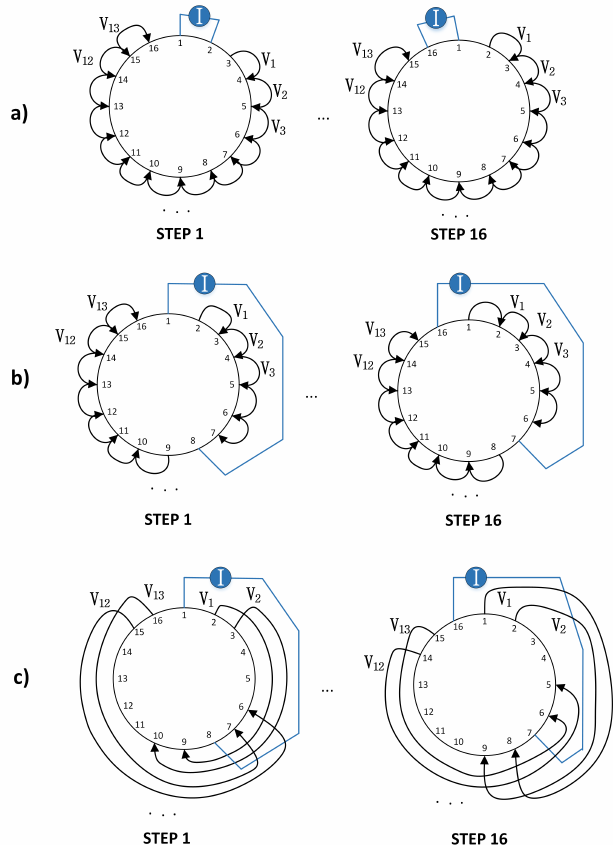
Figure 3. From top to bottom, the first and last of sixteen steps for the ( a ) Adjacent (AD); ( b ) Pseudo-Polar (PP) and ( c ) PP-PP drive patterns for a 16-electrode system. For each injection step, current is applied between a pair of electrodes and the resulting voltage is measured between the remaining pairs. The current excitation and voltage measurement is then rotated until the last